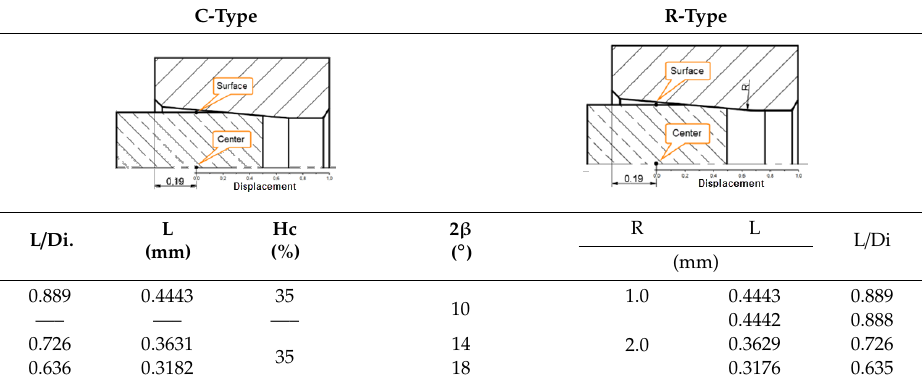
Table 2. Dimension of die geometry used in numerical